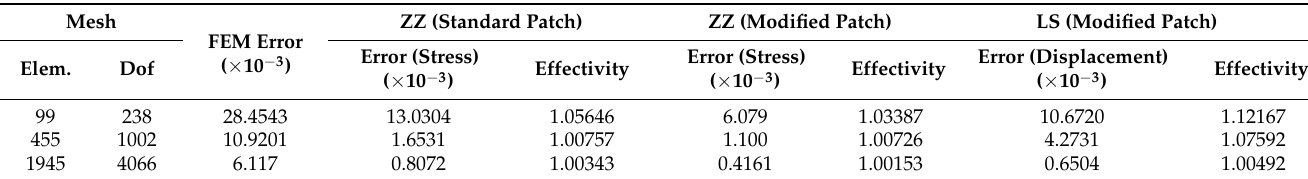
Table 6. Solution error and global effectivity ( θ ) for the plate problem using stress/displacement recovery and patch configuration (irregular linear quadrilateral element).